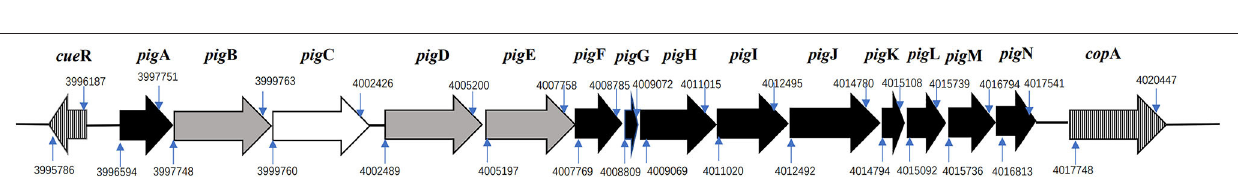
FIGURE 1 | Global multiplealignments of chromosomes from six Serratia strains using progressive MAUVE with default parameters. Colored blocks indicated the genome sequences that aligned to part of another genome and was possibly homologous and internally free from genomic rearrangement (locally collinear blocks). White regions represented sequences that did not aligned and probably contained sequences specific to a particular genome. Blocks below the center line showed regions that aligned in the reverse orientation. The names of the strains were listed at the bottom of the blocks.